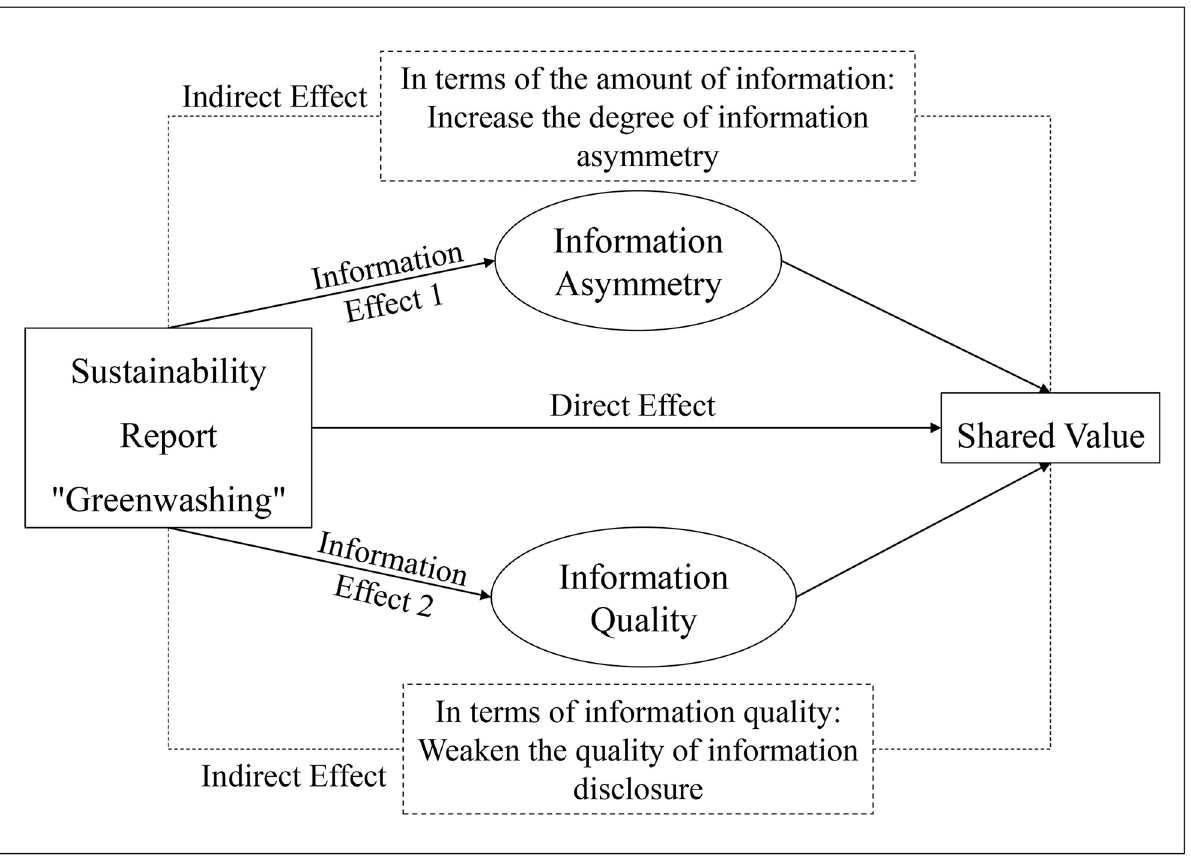
Fig 4. The research framework of this